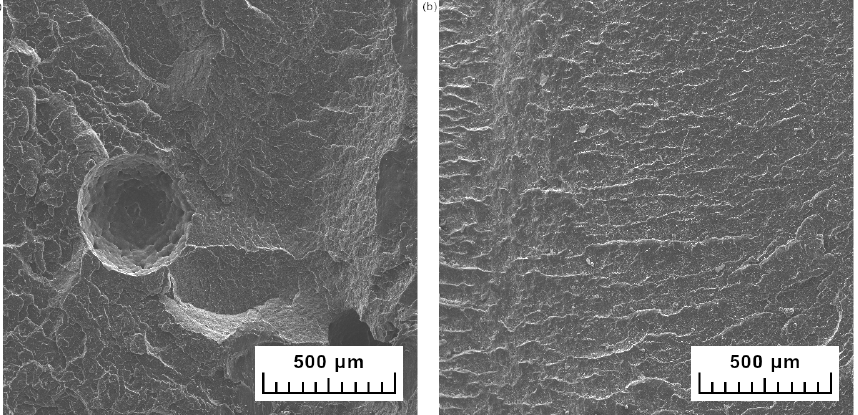
Figure 6. SEM images of cryo-fractured rotomolded samples of neat biobased HDPE made from powder ( a ) and extruded polymer ( b ).